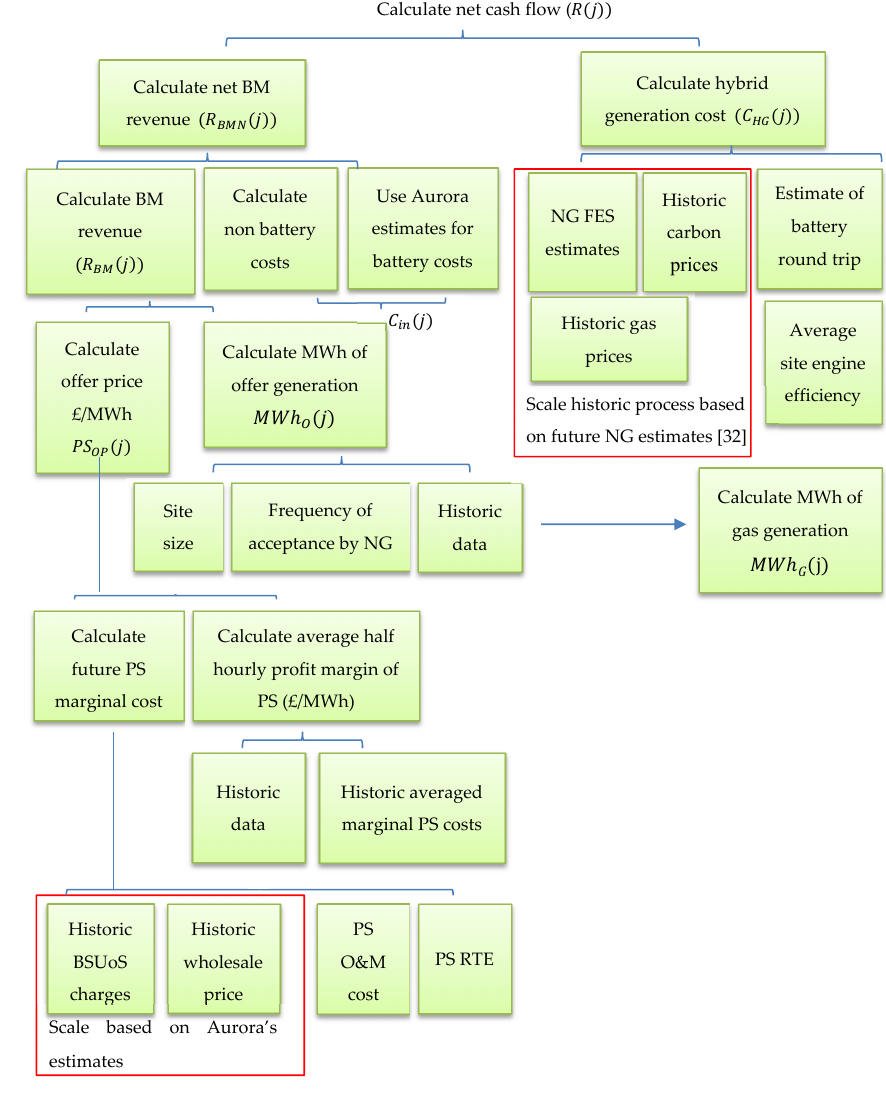
Figure 10. Hybrid operation net cash flow calculation each year.